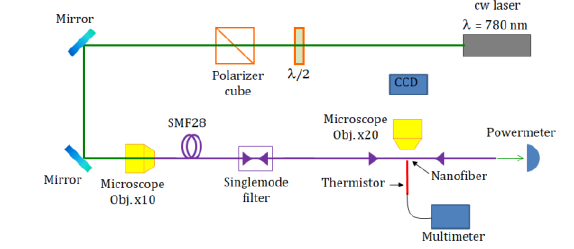
Fig. 2. Experimental setup for the direct measurement of the laser induced temperature of the nanofiber.